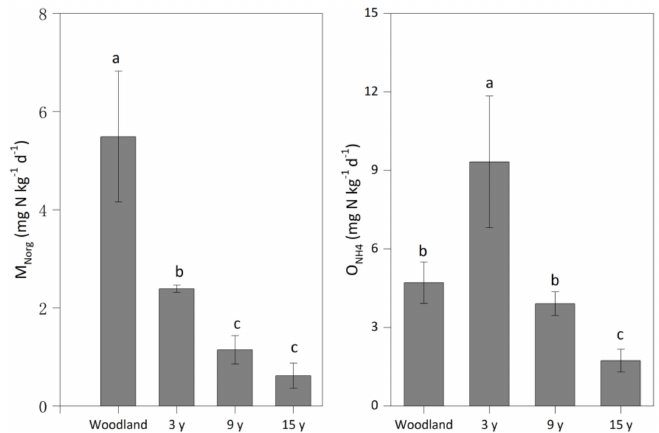
Figure 2. The mineralization (M Norg ) and nitrification (O NH4 ) rates in soils under woodland and three pitaya plantations. Error bars depict standard deviations. Identical letters for M Norg or O NH4 indicate no significant differences between woodland and pitaya plantations at p > 0.05.